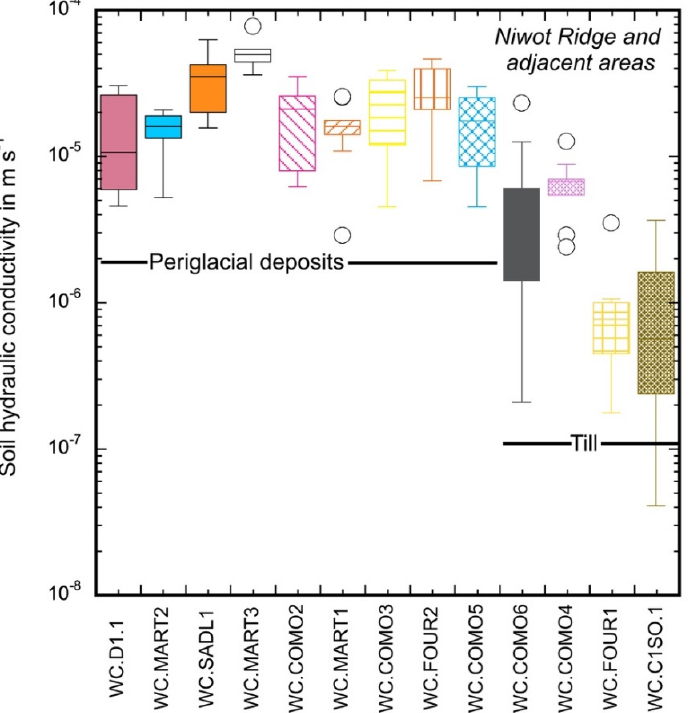
Figure 4. Box-and-whisker plot of measured hydraulic conductivity, Niwot Ridge. Transects are ordered from highest (D1.1) to lowest elevation (C1SO.1). Each site includes 10 measurements; 6 extremely slow rates were not included in the analysis. White circles mark outliers.